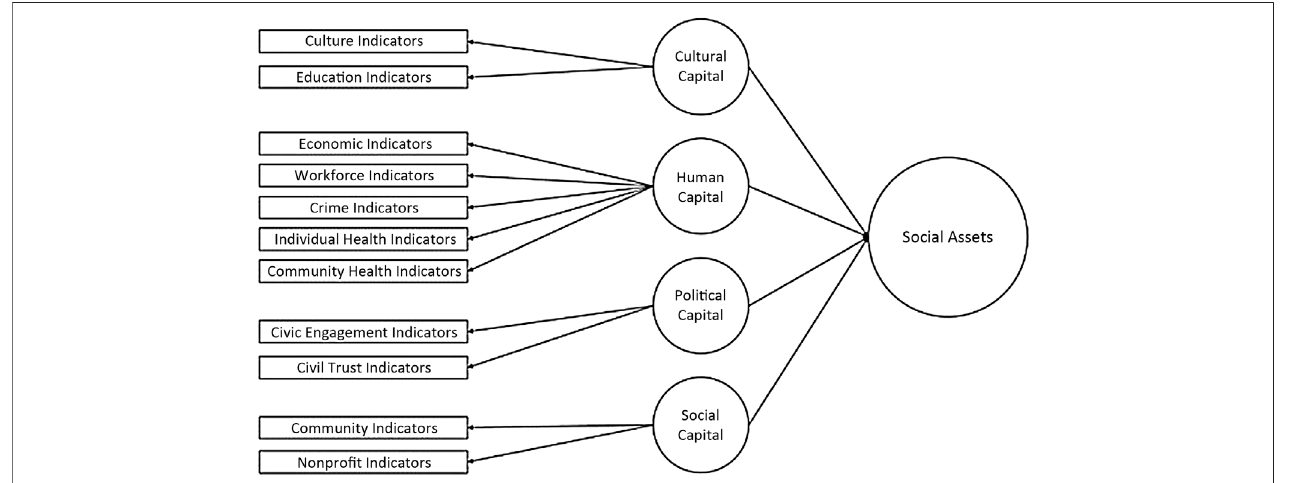
FIGURE 1 | Visualization of the community assets and attributes model. Note: Based on Mueller et al. (2020).